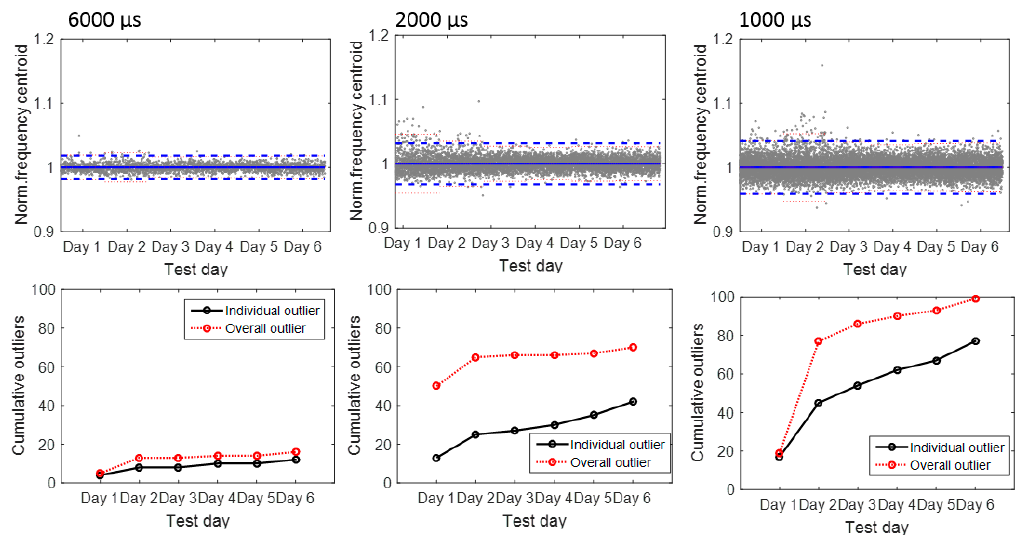
Figure 17. The outlier prediction with different window sizes.